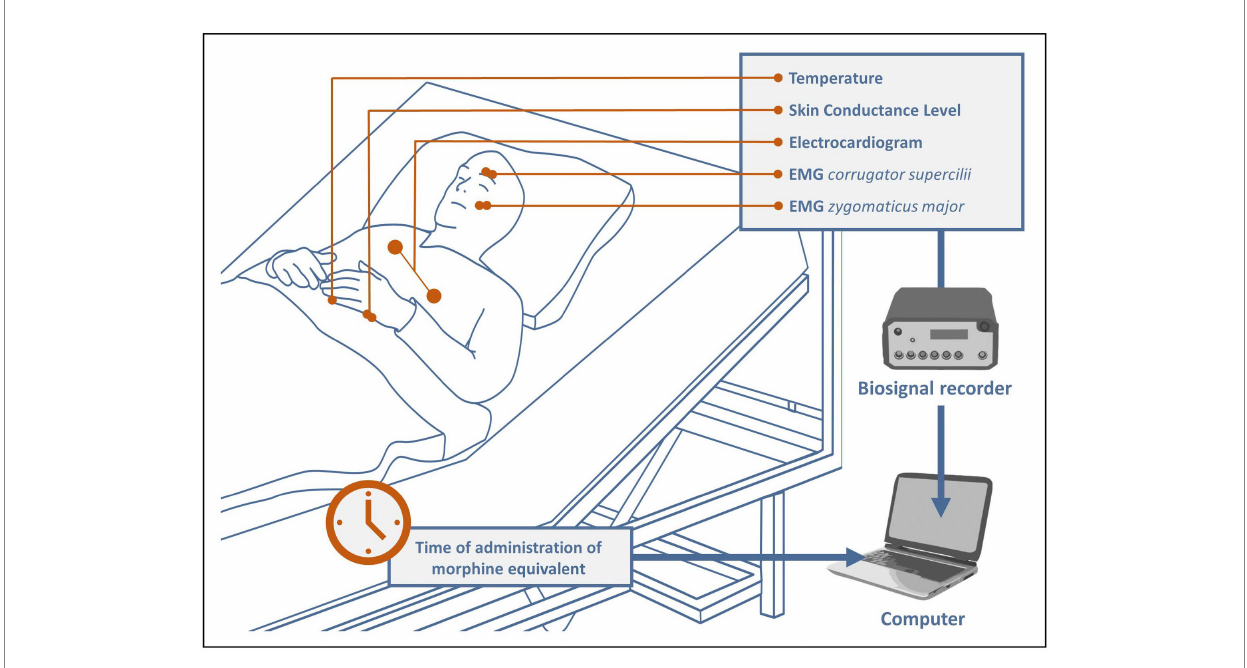
FIGURE 1 Study setup. EMG ≙